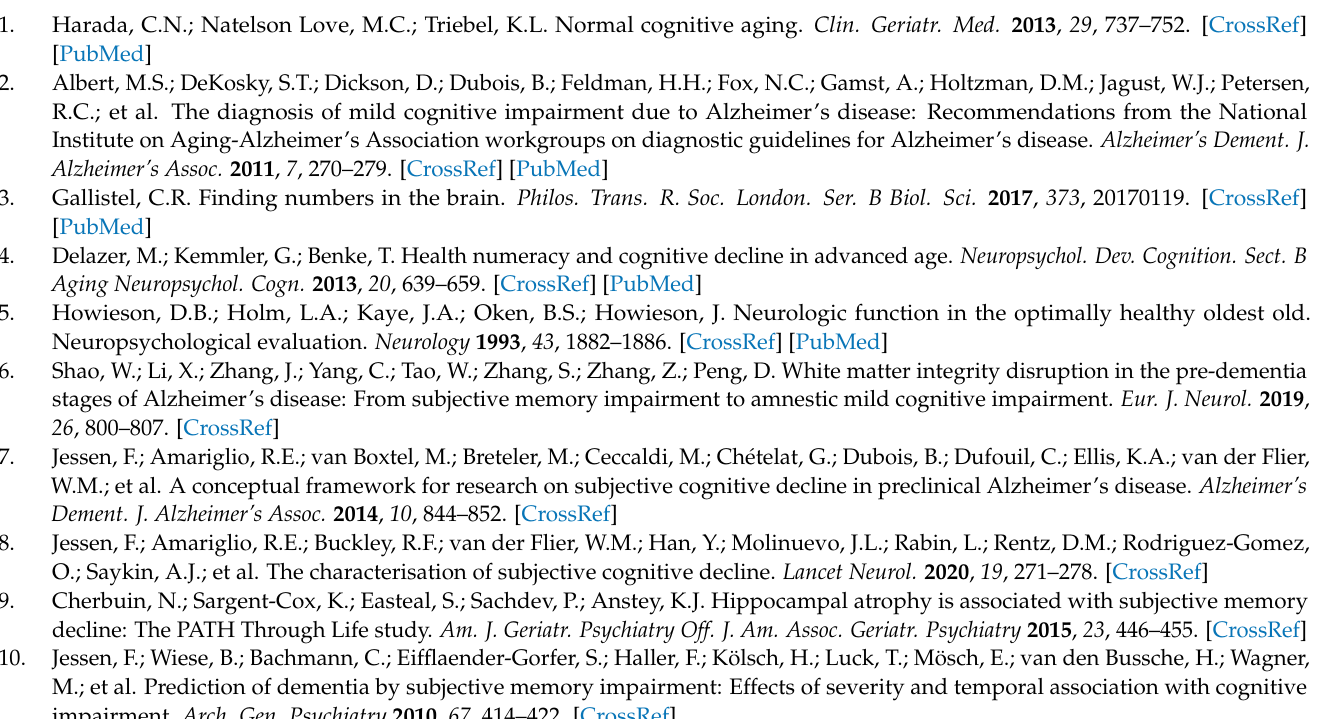
S3. Summary table of findings in relation to the trajectory hypotheses. Table S4. Characteristics of the attrition and the analytic sample on the baseline. Table S5. Results of the univariate and conditional linear Latent Growth Curve Models among participants without